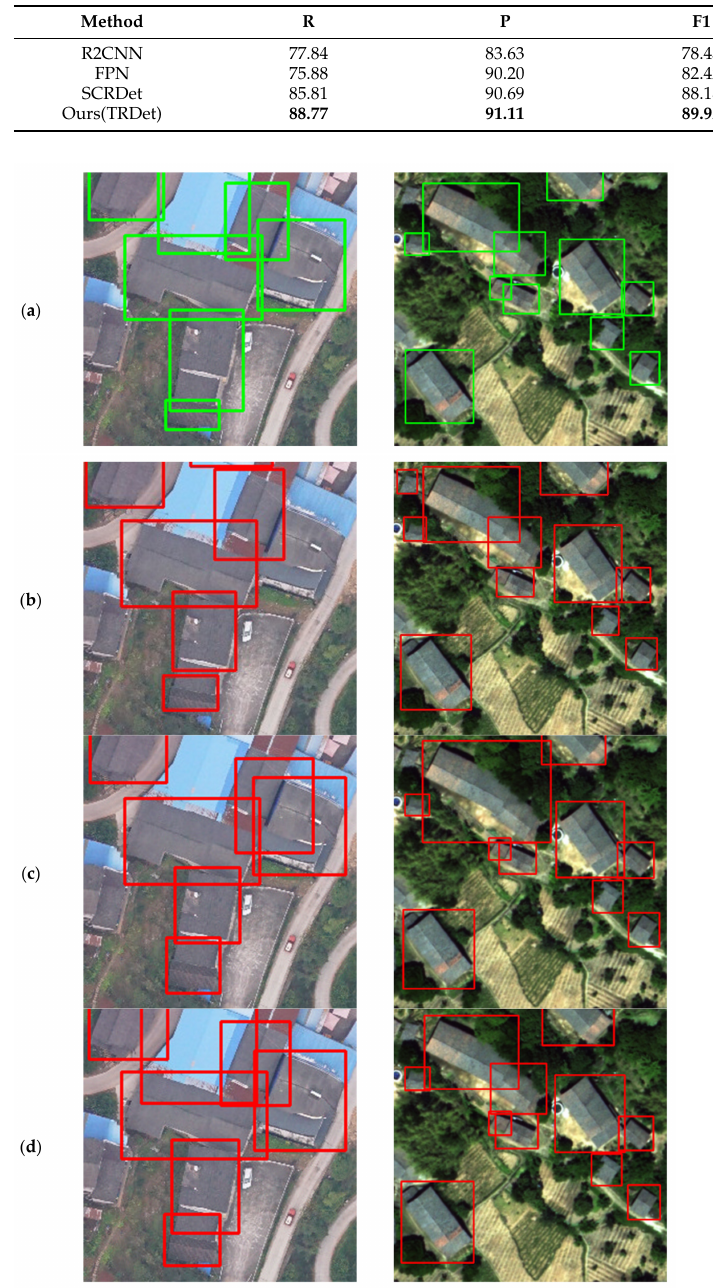
Table 6. Performance comparison of HD task.